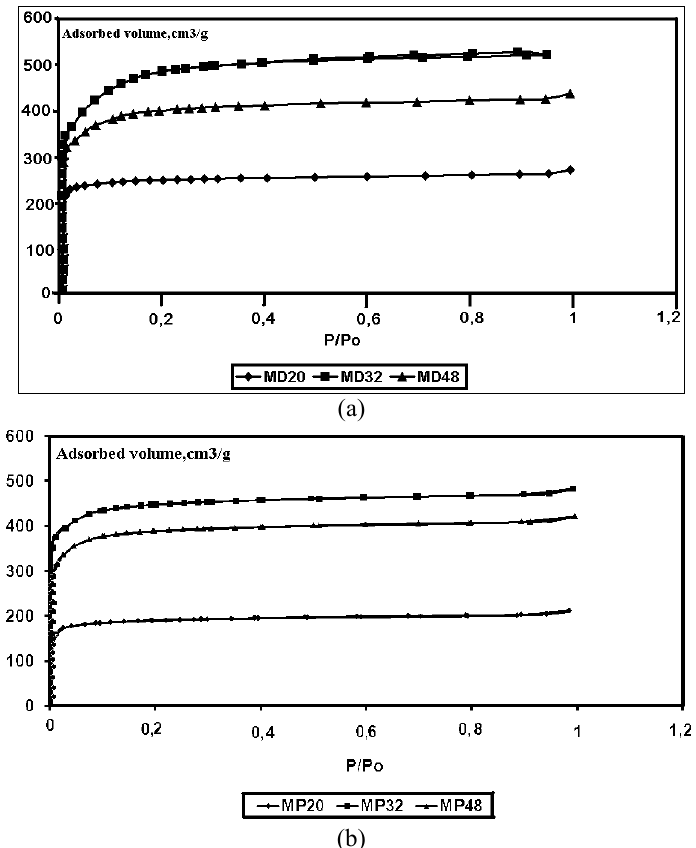
Figure 2. Adsorption isotherms of N at 77 K) Discs b) Honeycomb at different 2 concentrations of ZnCl 2